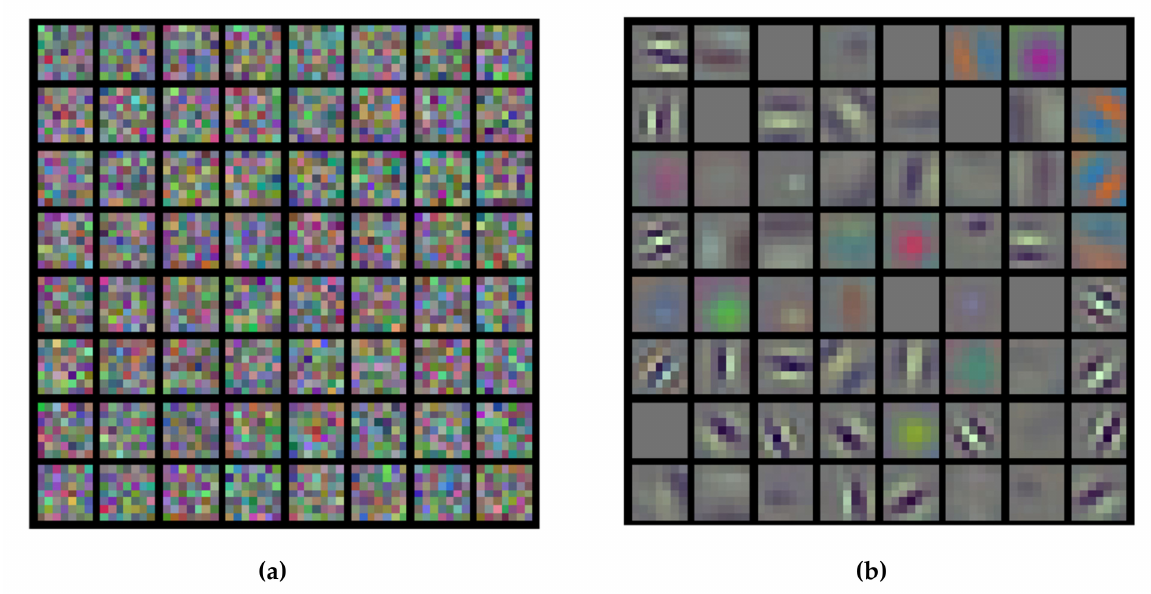
Figure 11. Weights for the first convolutional layer for ResNet18 used for the classification of the thin-section data: ( a ) baseline weights; ( b ) ResNet18 pretrained on ImageNet and fine-tuned on the thin-section dataset.